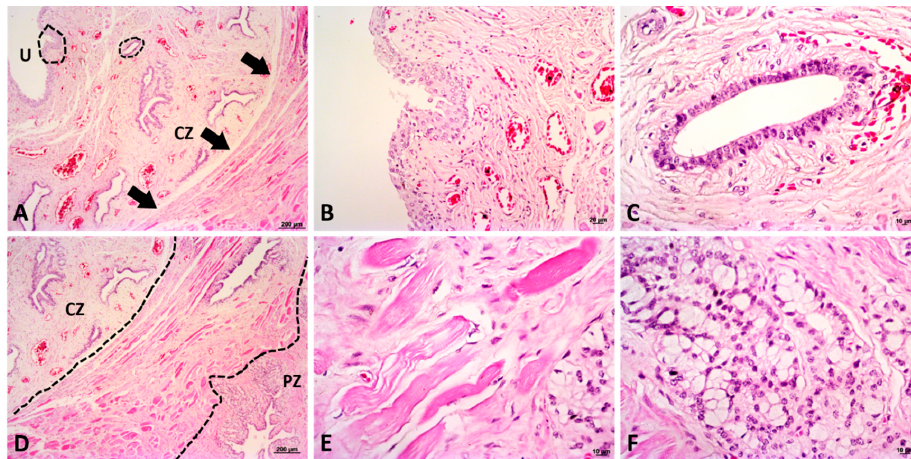
Figure 3. Histological representation of the different prostatic zones. ( A ): low magnification (5 × ) of central zone of the prostate gland, showing the prostatic urethra (U) and a high density of blood vessels and ducts. The lined circles represent a higher magnification of the prostatic structures showed in figures B and C. It is also possible to observe a muscle-rich stroma surrounding the central zone (arrows). ( B ): a high magnification (20 × ) of the prostatic urethra. ( C ): a higher magnification of a prostatic duct of the central zone (CZ). ( D ): a low magnification (5 × ) of the division of both zones: central zone (CZ) and peripheral zone (PZ). The muscle-rich stroma surrounds the prostatic urethra (in the middle of the dotted lines), dividing the central zone (enriched by ducts) and peripheral zone (enriched by luminal glands). ( E ): a higher magnification (40 × ) of the stroma dividing both zones. This region is composed by a muscle-rich stroma. ( F ): luminal glands from the peripheral zone (in the figure D, showed in the lower left side). Hematoxylin and eosin